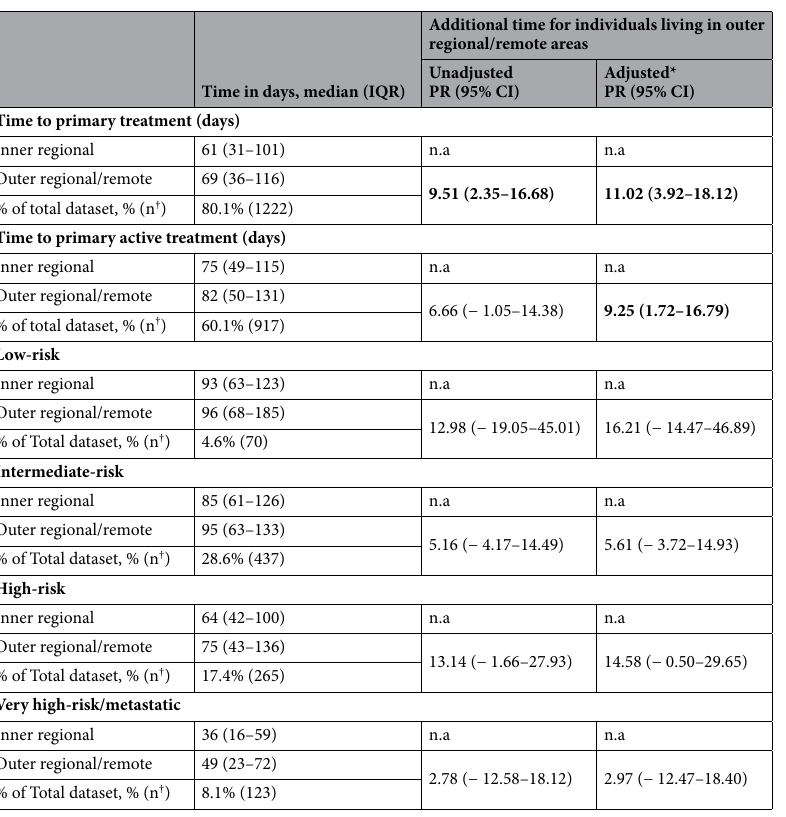
Table 4. Differences in time and distance travelled to primary treatment for men with prostate cancer in inner and outer regional/remote areas of Tasmania. IQR = Interquartile Range; PR = Prevalence Ratio; CI = Confidence Interval; n.a. = Not Applicable. *Adjusted for age at diagnosis. † All analyses are weighted for remoteness classification (see “Methods”). Subject numbers are rounded to the nearest integer